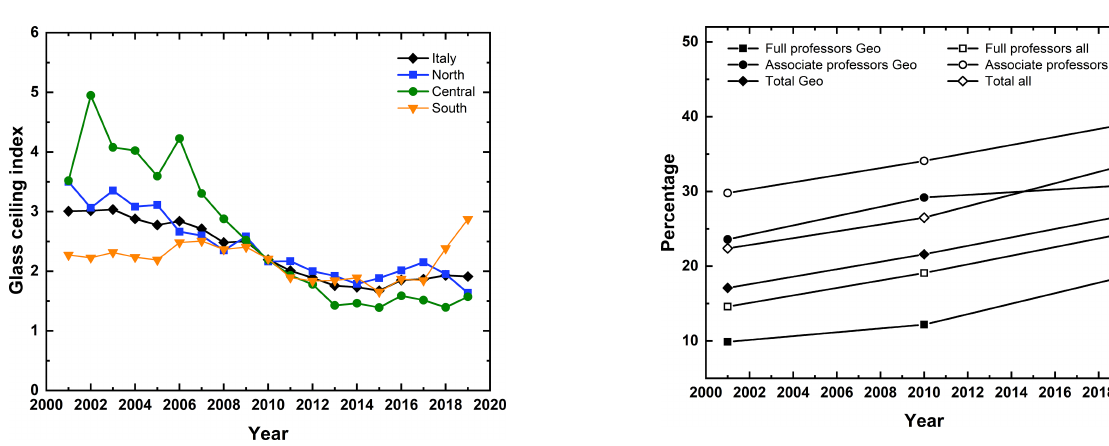
Figure 7. Comparison between percentages of female professors (F. P.: full professors; A. P.: associated professors; T. P.: total number of professors) in geosciences (indicated as GEO) and the average from all Italian disciplines (indicated as ALL) (data source: MIUR, https://cercauniversita.cineca.it/php5/docenti/cerca. php, last access: 31 October